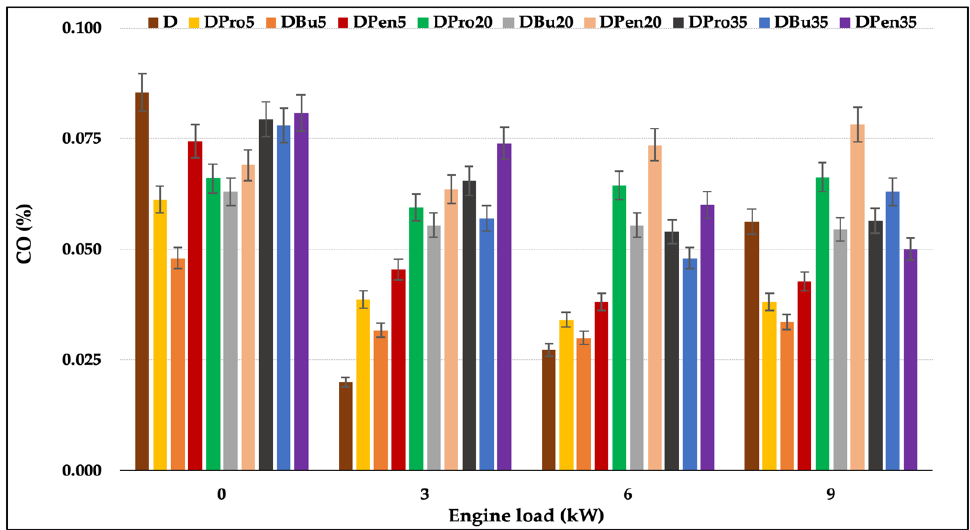
Figure 3. Comparison of CO emissions with engine load for test fuels